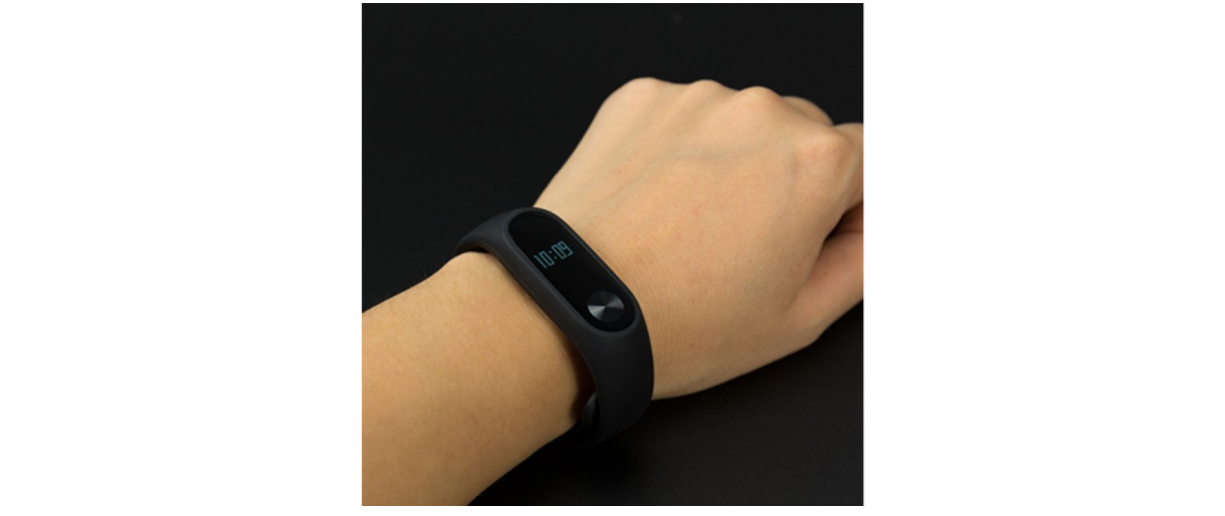
Figure 2. The Mi Band 2.